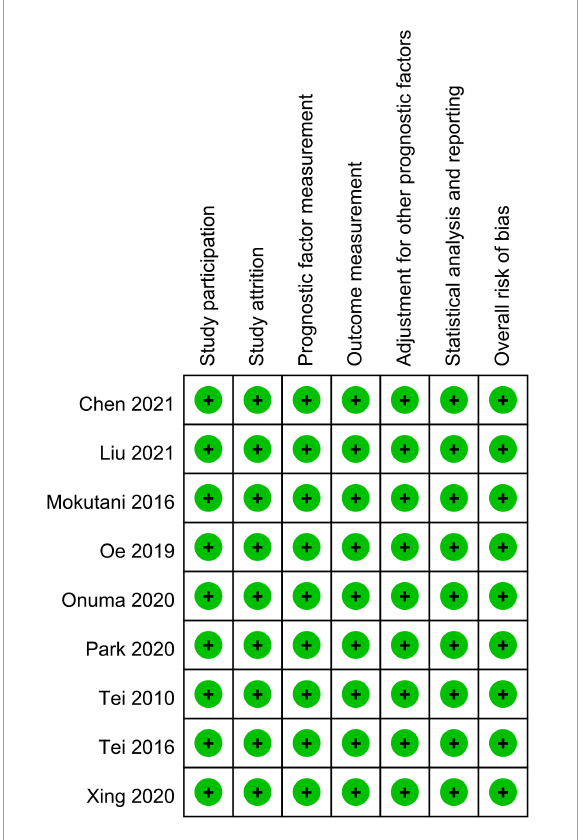
FIGURE2 Summary of different categories of risk of bias of the included studies. Green, low risk of